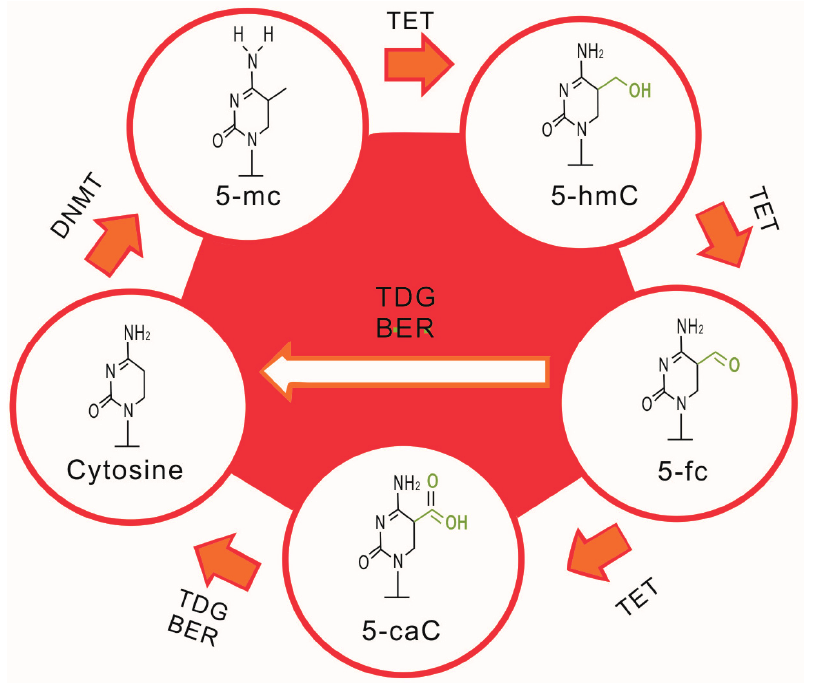
Figure 2. The cycle of DNA methylation and